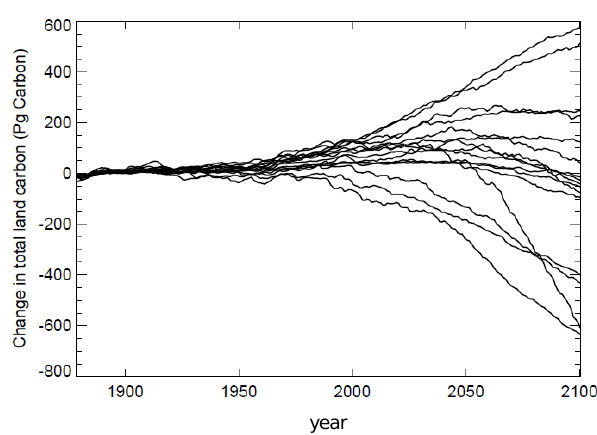
Fig. 2. Simulated change in terrestrial C-pools over the late 19th and 20th century, and until 2100, in 17 versions of HadCM3C, a fully coupled climate-carbon cycle model. Future projections are driven by a single emission scenario, SRES A1B. Spread between the land carbon responses illustrates uncertainty in the terrestrial response arising from perturbations, within plausible ranges, to six key parameters related to vegetation carbon and water balance using a design that minimises correlations between parameters (for details see Booth et al.,